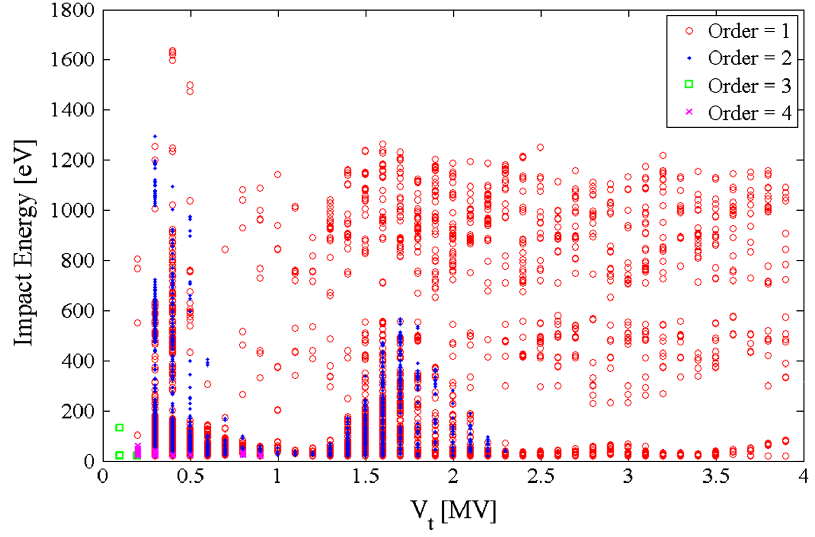
FIG. 9. Electron impact energy in the 400 MHz rf-dipole cavity with varying transverse voltage.